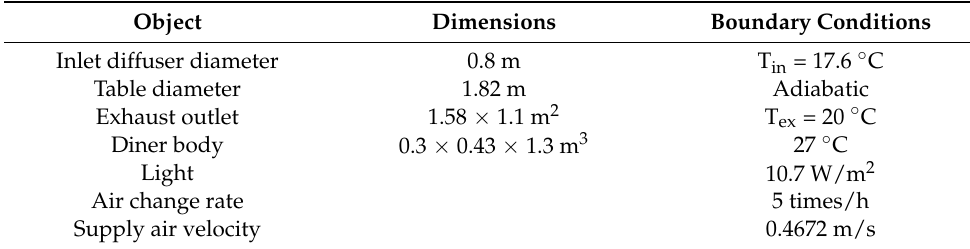
Figure 10. Computer model and components of the ballroom ： ( a ) the placement of exhaust outlets and diffuser inlets; ( b ) the locations of all occupants; ( c ) the location of the infected occupant. Table 6. Ballroom specifications.